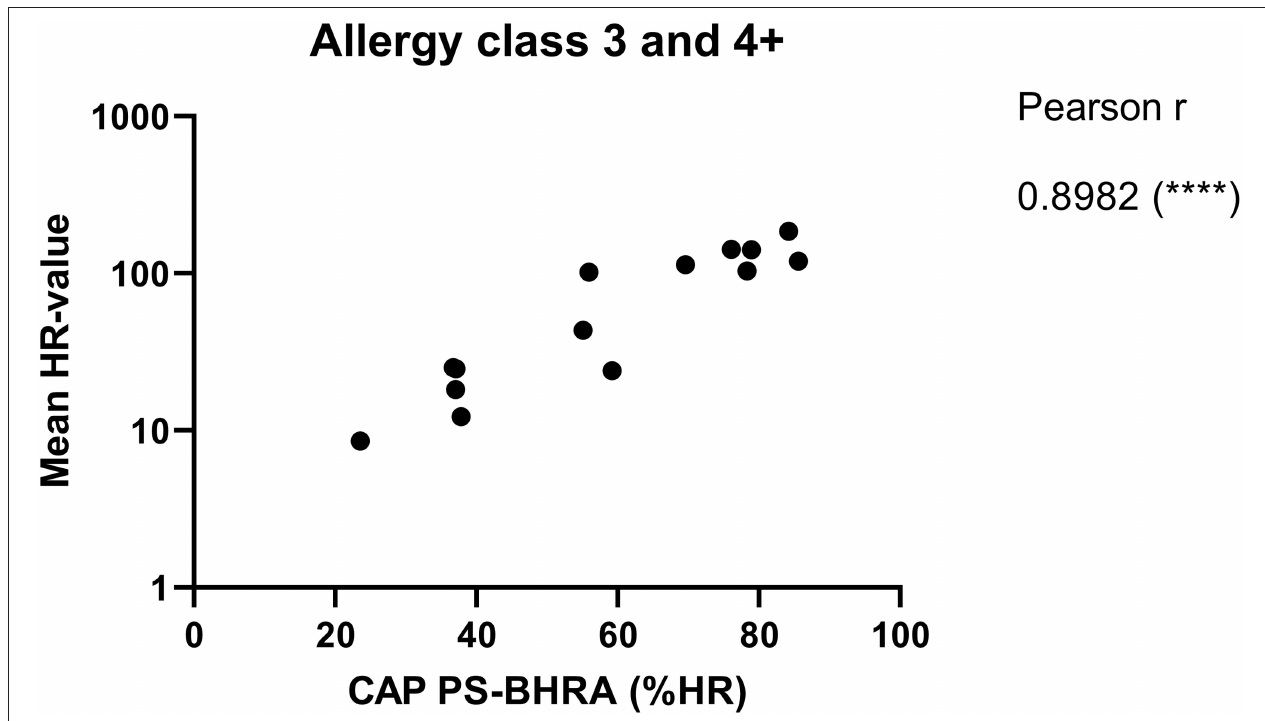
FIGURE 5 | Mean of the HR-value from the 3 experiments correlated with PS basophils activated by matrix fixed allergen (CAP PS-BHRA) for the allergy classes 3 and 4 + sera. Pearson